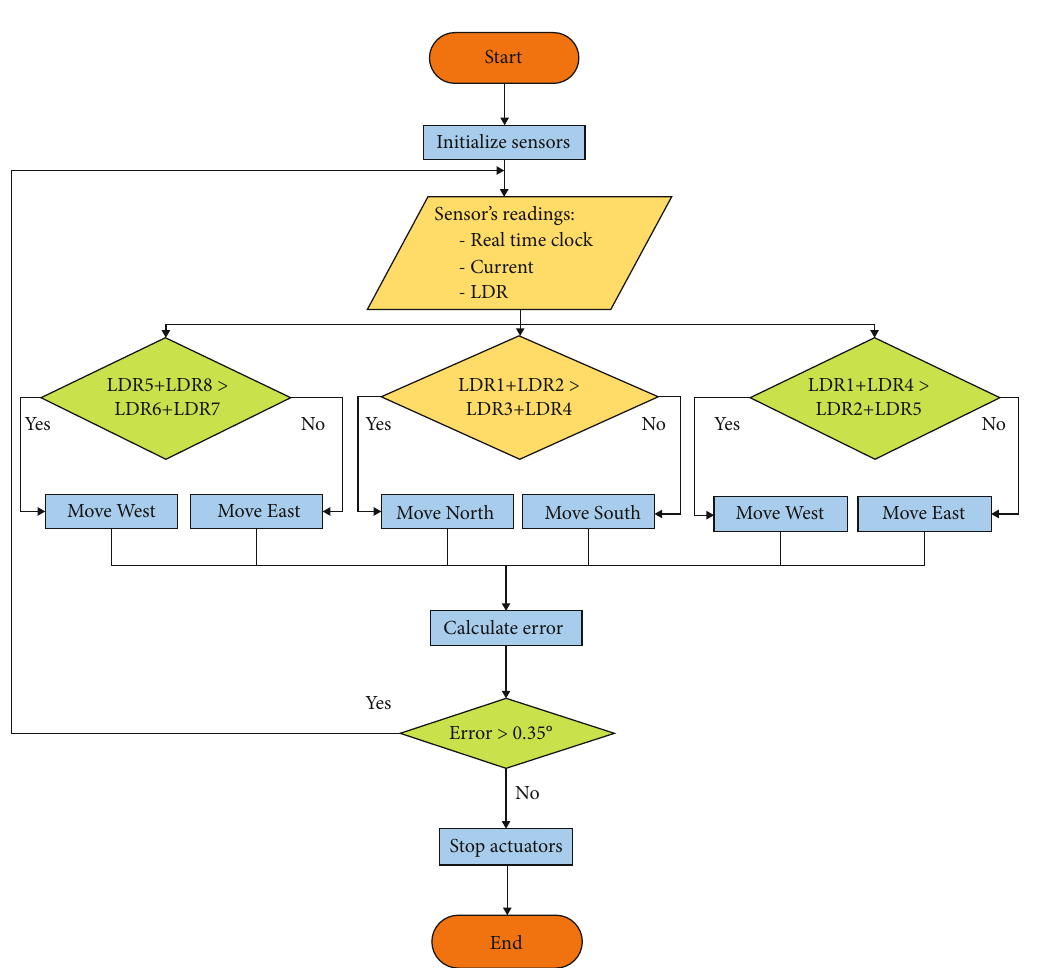
Figure 5: SAST and DAST working principle ’ s fl ow chart.